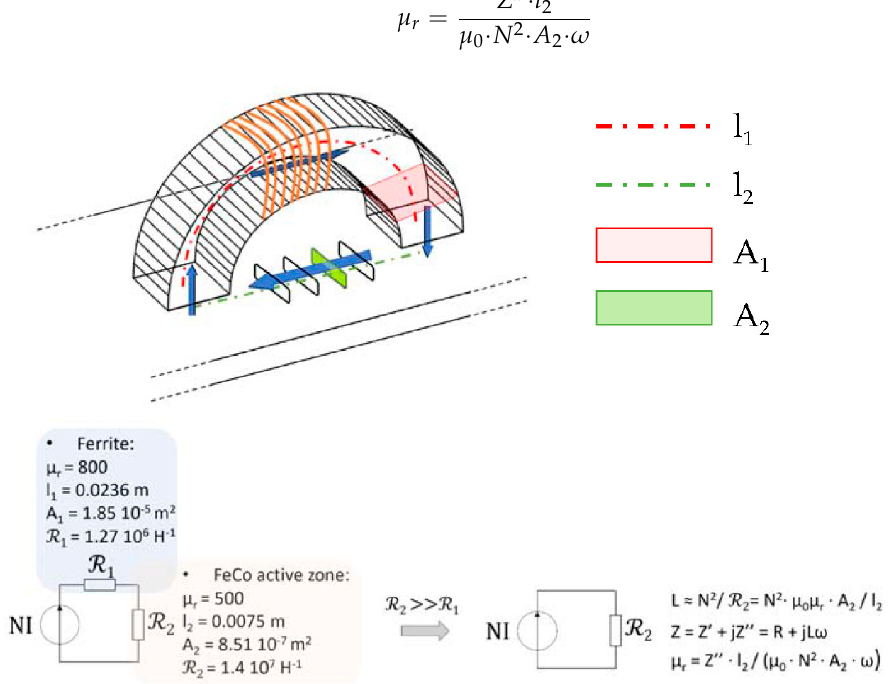
Figure 10. Simplified reluctance scheme for a linear relation between Z ″ and μ r .